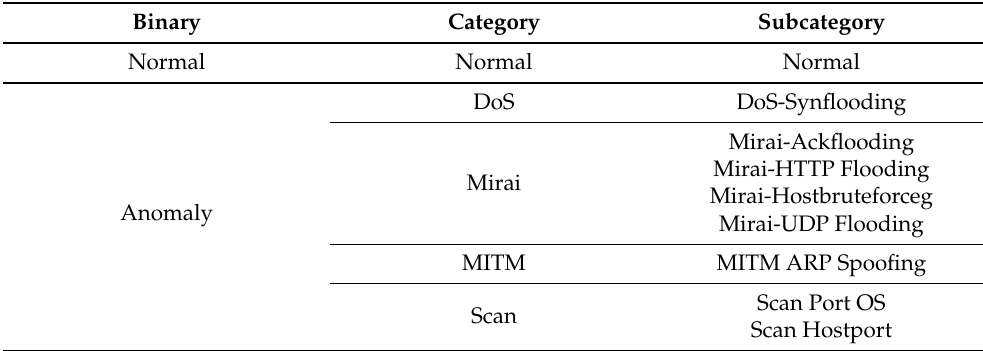
Table 2. Label details of IoTID20